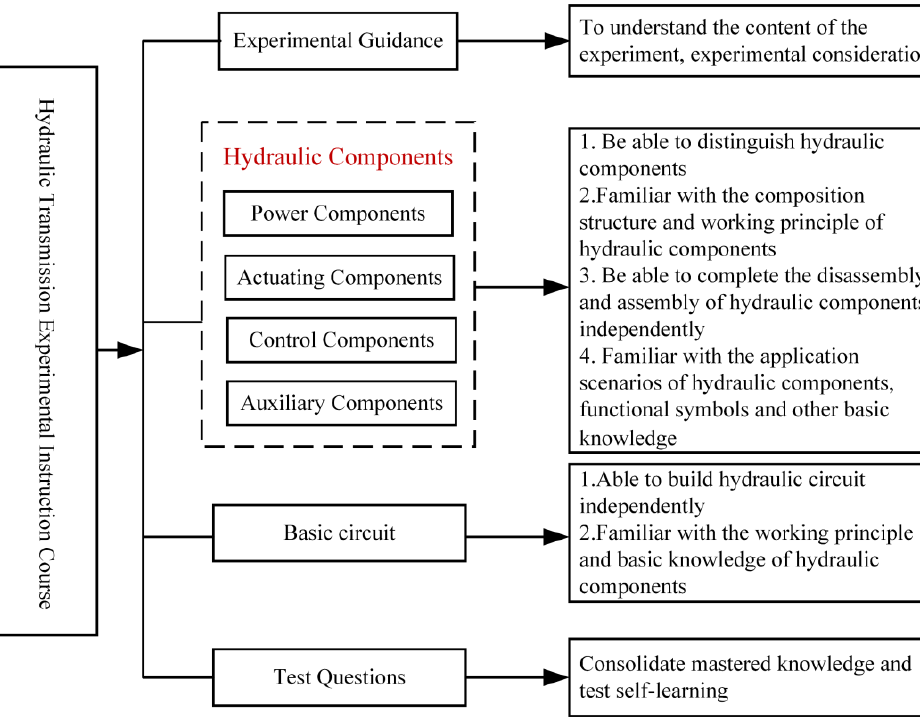
Figure 2. Course content of “ Hydraulic Transmission ” .